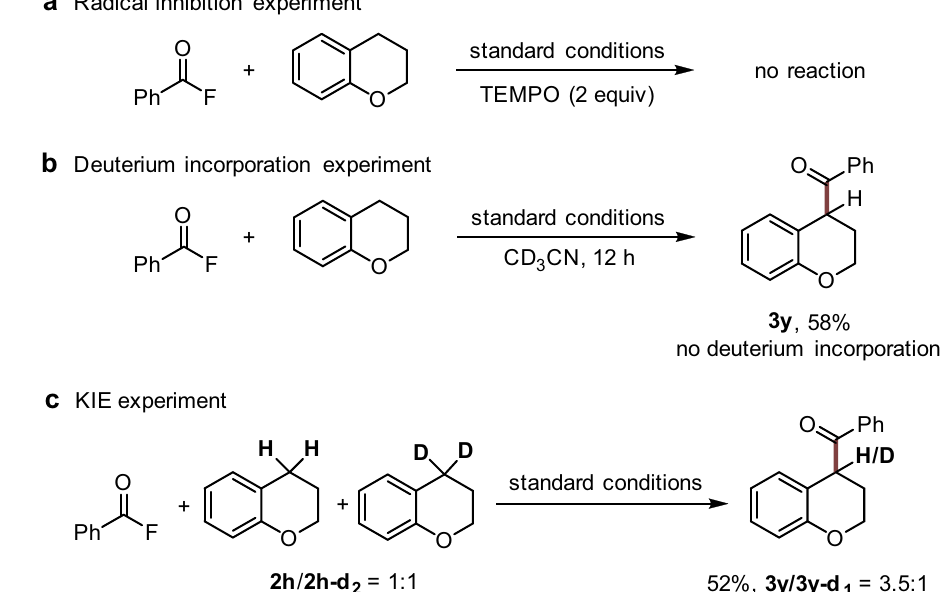
Fig. 4 Control experiments. a Radical inhibition experiment. b Deuterium incorporation experiment. c KIE experiment. TEMPO 2,2,6,6-tetramethyl- piperidin-1-oxyl, KIE kinetic isotope effect.